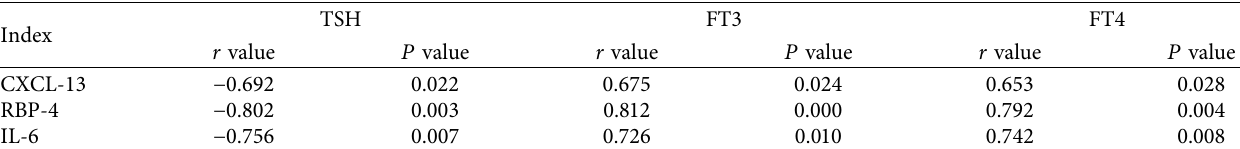
Figure 2: Comparison of serum CXCL-13, RBP-4, and IL-6 levels in patients with different a degree of GD. Note: compared with mild P group, 0 . 05; compared with the moderate group, # P of RBP-4 levels; (c) represents a comparison of IL-6 levels. ∗ < Table 2: Correlation between serum CXCL-13, RBP-4, and IL-6 levels, and thyroid function in GD patients.